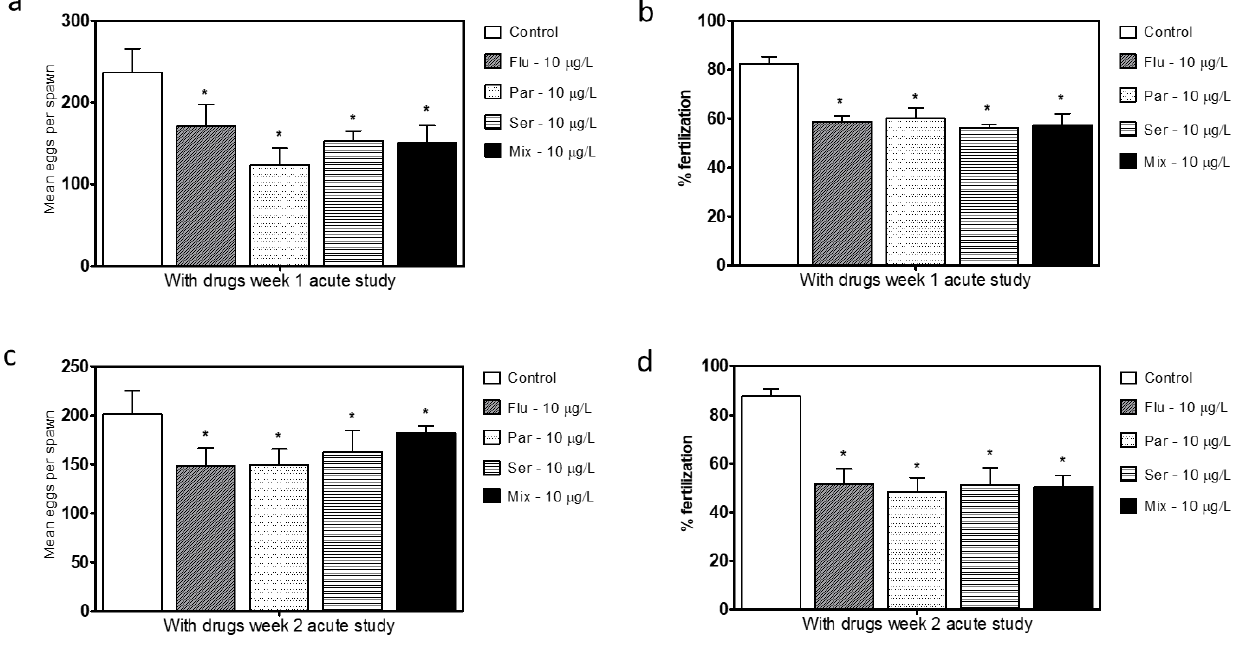
Figure 6. Mean number of eggs generated per single pair cross (all eggs regardless of viability) following the short-term exposure period during week 1 ( a ) and week 2 ( c ) for all treatment groups (Flu- Fluoxetine, Par — Paroxetine, Ser — Sertraline, Mix — mixture of all three compounds). Percent fertilization of clutches during week 1 ( b ) and week 2 ( d ). Statistical significance with respect to the control fish group was determined using a one-way ANOVA followed by a Dunnett’s multiple comparisons test (* p < 0.05).